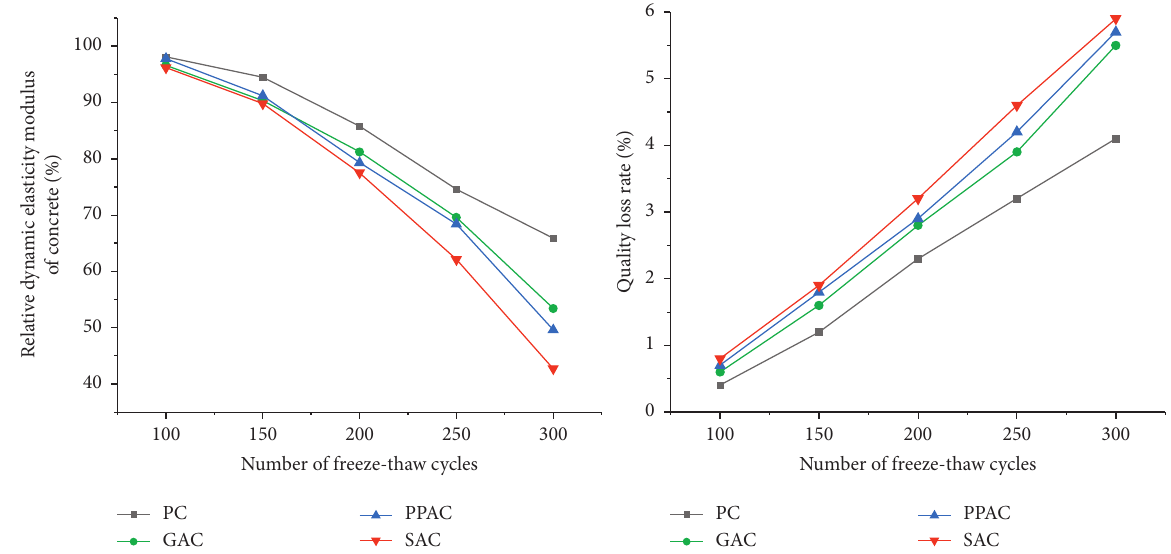
Figure 22: Relative dynamic modulus and mass loss rate of three kinds of OSWA in place of cement. Table 13: Relative durability